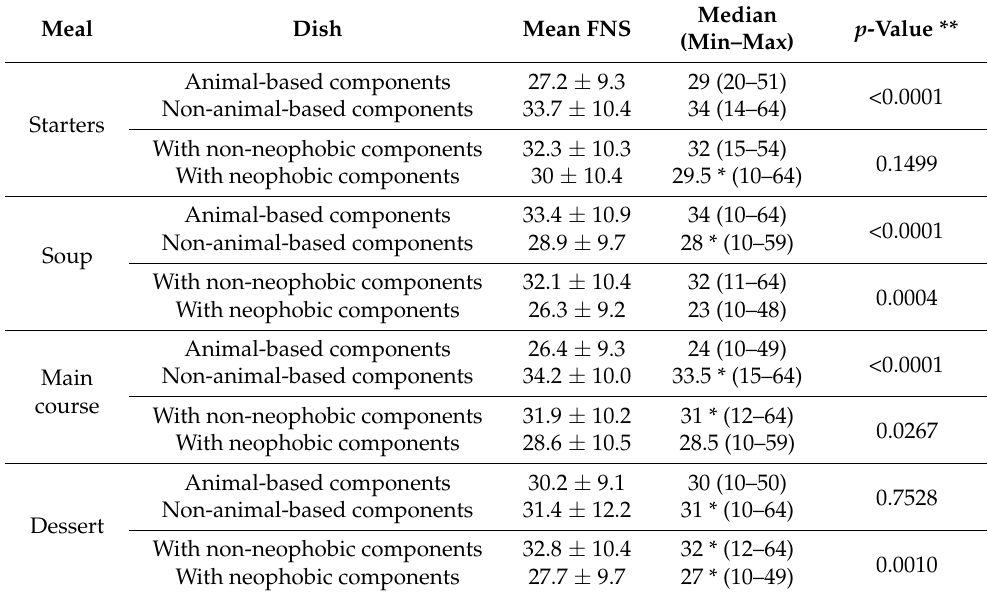
Table 7. The comparison of the food neophobia level among the studied sample of young Polish women. The dishes from the model French restaurant menu are organized into sub-groups and the food neophobia level of the dishes is stratified according to whether they contain animal-based components/non-animal-based components, or non-neophobic components/with neophobic compo- nents.